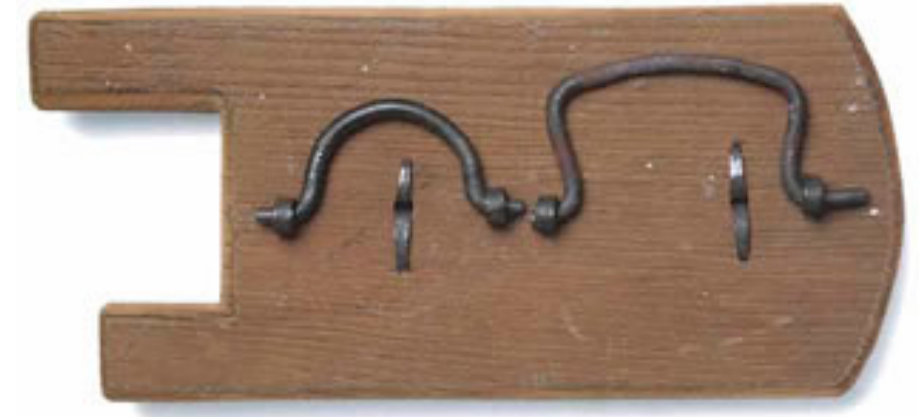
Figure 1. Matracula , a percussion instrument still in use in Sardinia (Italy).